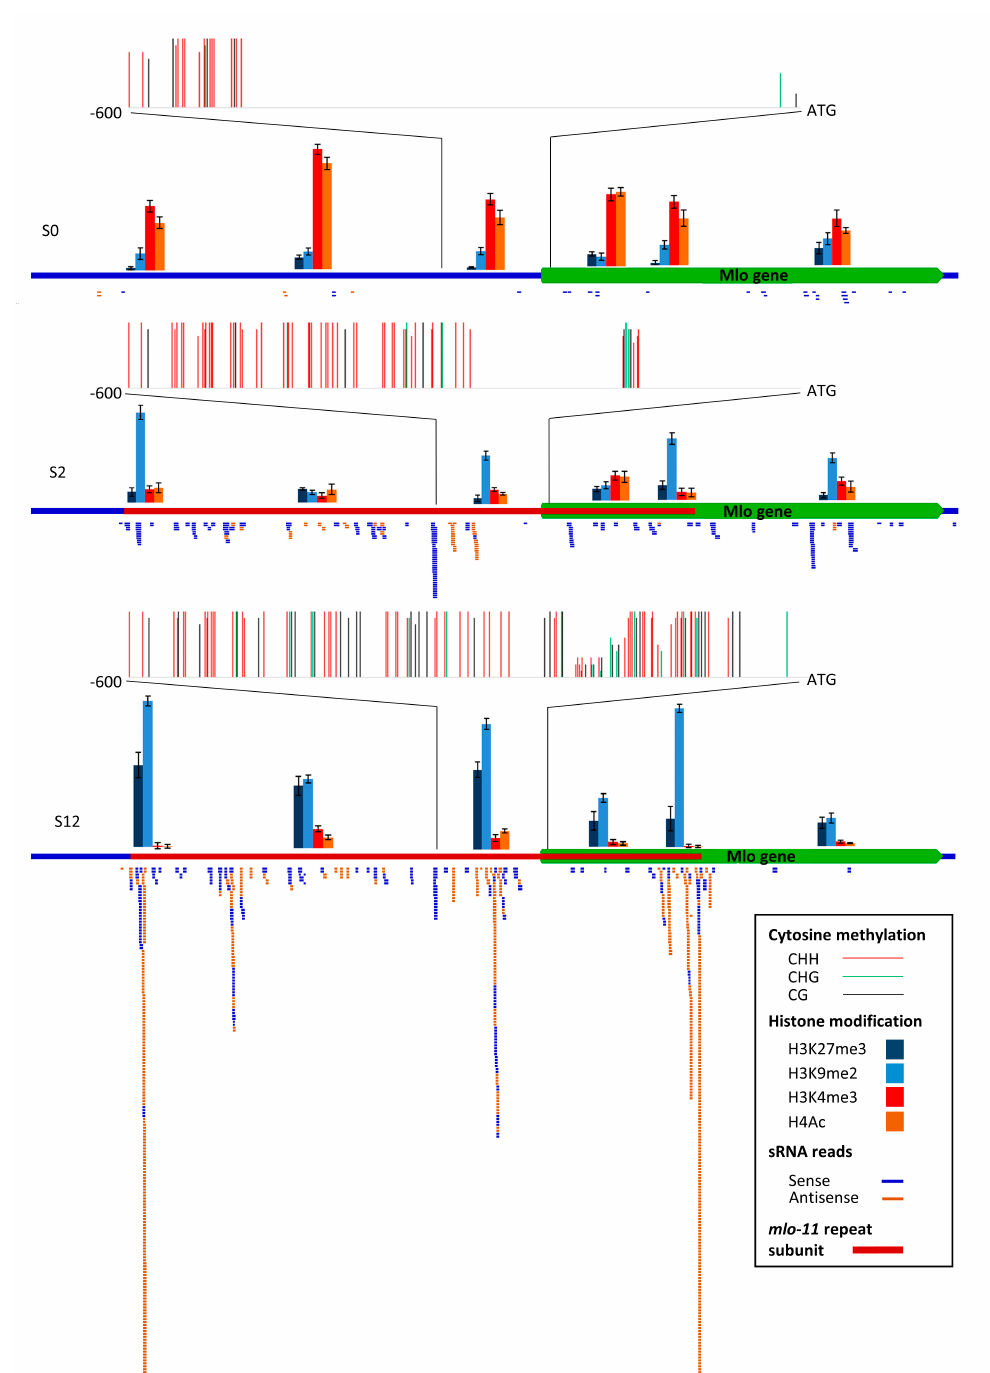
Figure 4. Evidence for small RNA (sRNA)-directed histone modifications at the mlo-11 subunit between Mlo wild type control (S0) and Baudin NILs containing mlo-11 ( cnv2 ) (S2) and standard mlo-11 (S12). The top panel shows methylation status of a 600 bp region determined by bisulphite sequencing. Red depicts methylation in the CHH context, green the CHG context, and black the CG context (where H = A, T, or C), scaled relative to presence in 10 sequenced replicates. The majority of cytosine methylation is in the CHH context. The middle panel shows levels of histone modifications in six regions determined by chromatin immunoprecipitation (ChIP) PCR. Each histone modification class is scaled is relative to the anti-H3 histone background control. The bottom panel shows sRNA reads mapped across the mlo-11 repeat